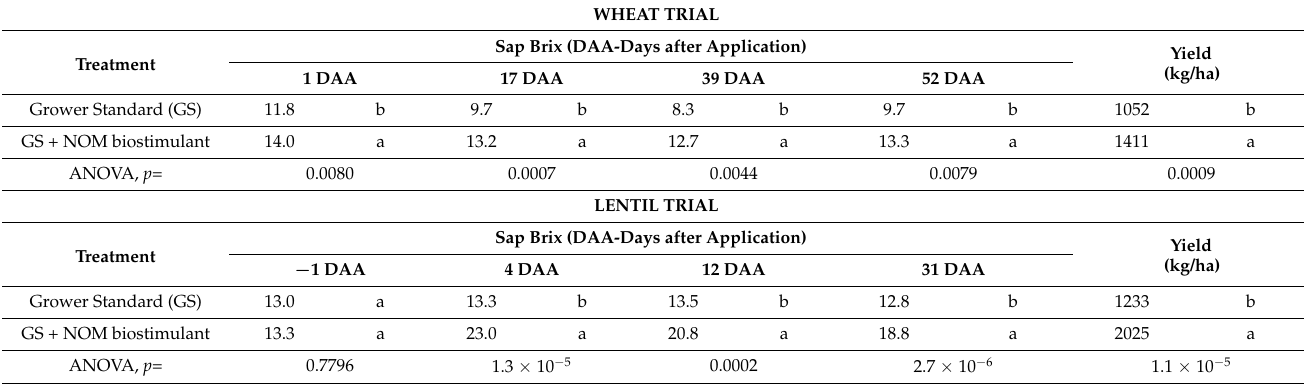
Table 2. Average sap Brix contents and yield data for the winter wheat and lentil trials in Australia for the grower standard (GS) plants and the GS + NOM-based biostimulant treated plants. Sap Brix was assessed throughout the season at various days after application (DAA). Means with the same letter designation within each column do not differ significantly ( p = 0.10, least significant